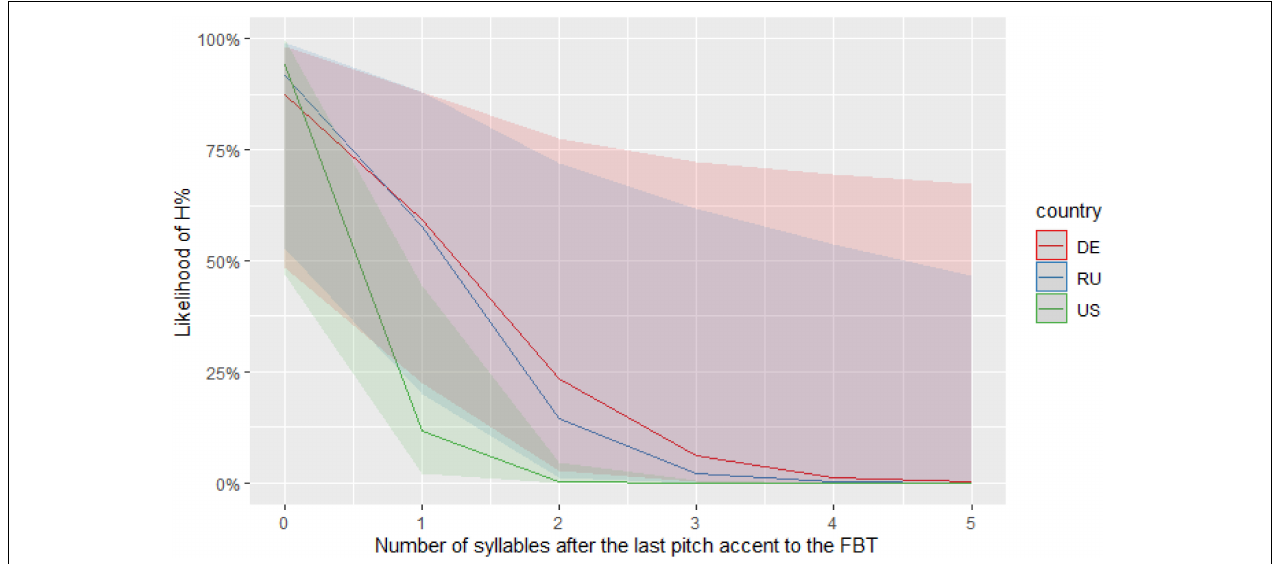
FIGURE 2 | Estimated likelihood of H% being chosen over L% based on the productions of the three speaker groups.